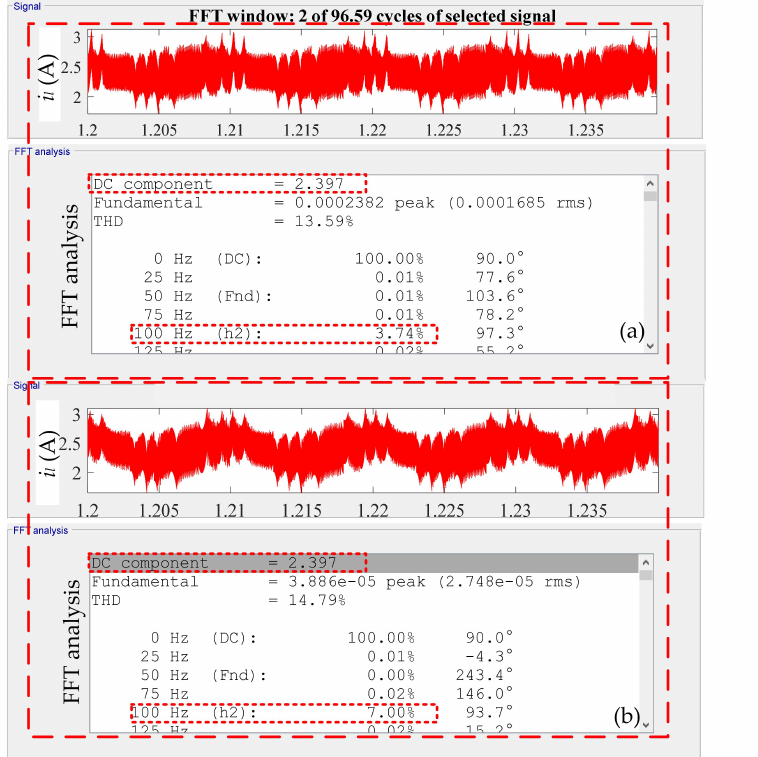
Figure 12. Inductor current when the harmonic source is placed at the output and GCF = 2 kHz: ( a ) PI controller and ( b )